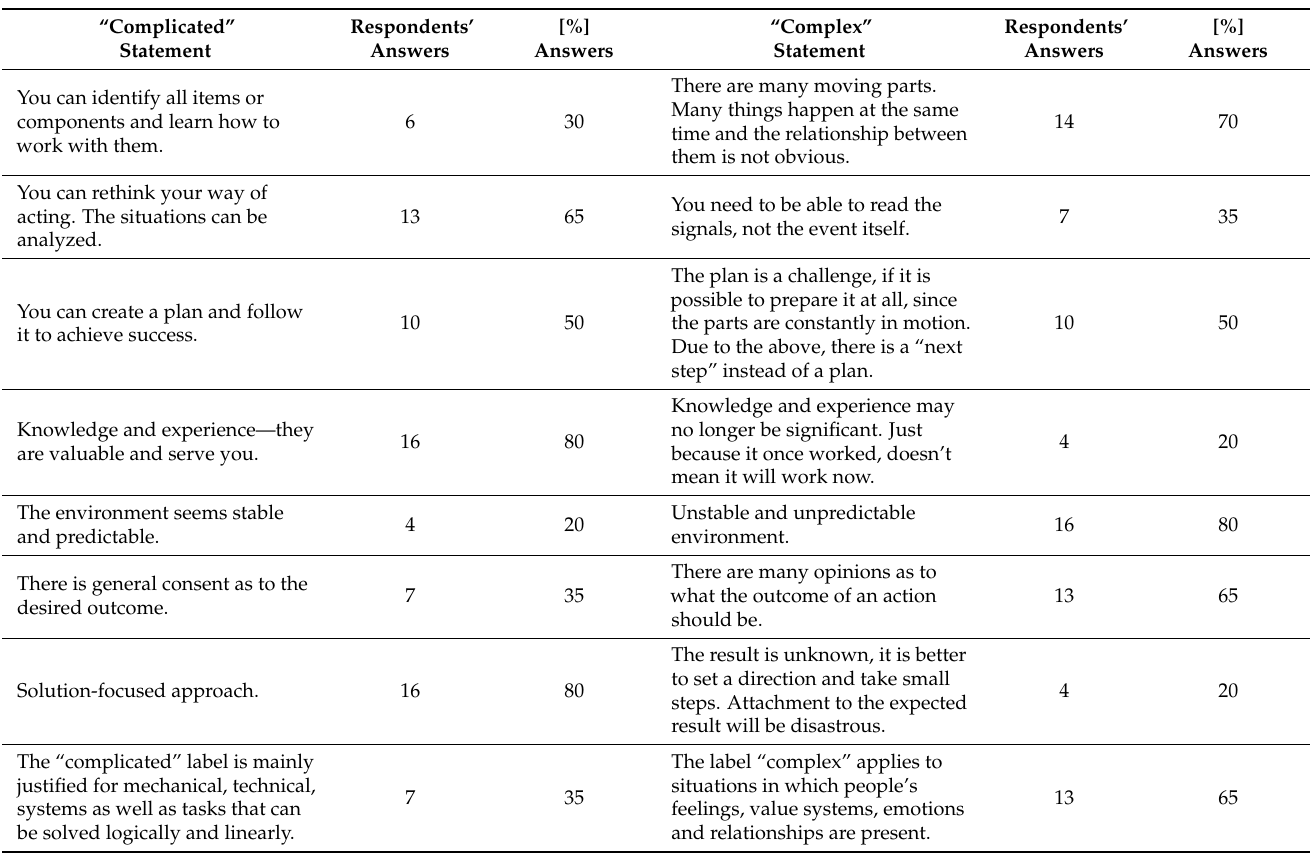
Table 2. Analysis of complicated vs. complex